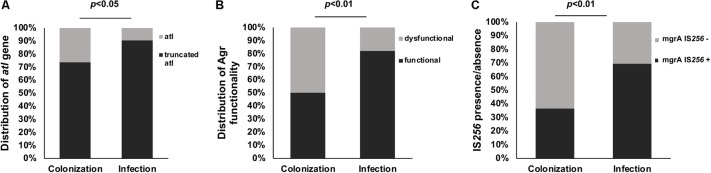
Differences in isolates collected from colonization and infection sites. (A) Percentage of truncated (black) and not truncated (gray) atl gene (PCR detected) in hundred ST239 isolates from Brazil collected from colonization and infection cases. (B) Distribution of functional (black) and dysfunctional (gray) Agr among 100 ST239 isolates obtained from colonization (n = 38) and infection cases (n = 62) in Brazil. (C) Presence (black) and absence (gray) of IS256 insertion in the mgrA gene in 100 ST239 MRSA isolates from Brazil collected from colonization and infection cases. Note a significantly increased number of IS256 insertion among infection cases compared with colonization cases (p-values calculated by Fisher’s exact).